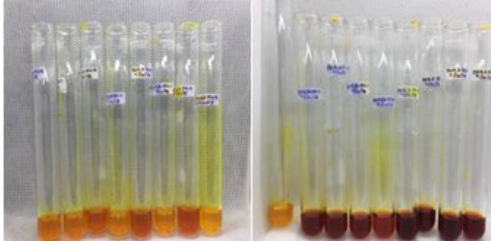
Fig. 7. Filtrate with the addition of 1% starch extract and DNS reagents before heating (left) and filtrate after heating